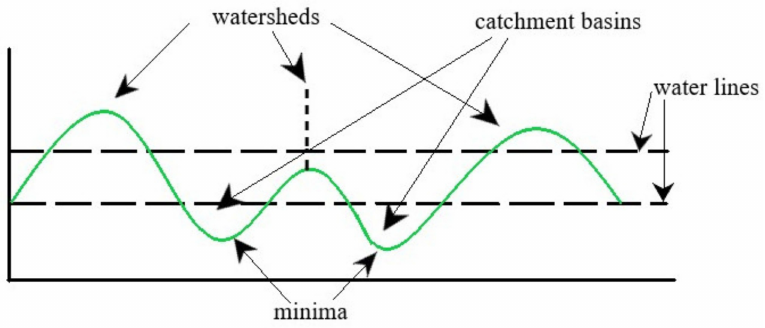
Figure 1. Watersheds and basins illustration.